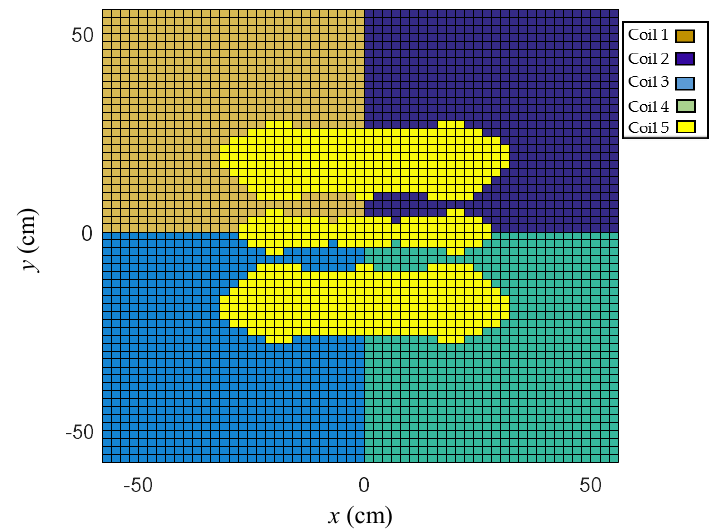
Figure 12. Transmitting coil activation at any point of the landing area using the same colors for the coils as in Figure 8.